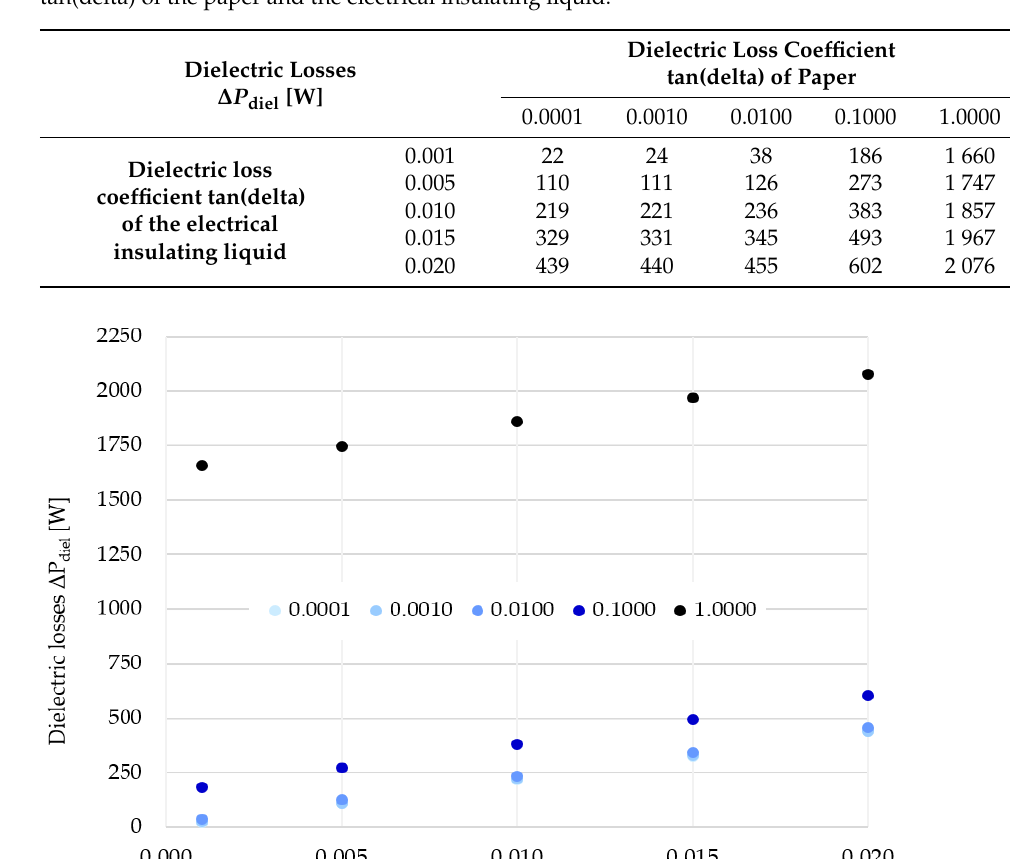
Table 5. Dielectric losses in the selected transformer depending on the dielectric loss coefficient tan(delta) of the paper and the electrical insulating liquid.